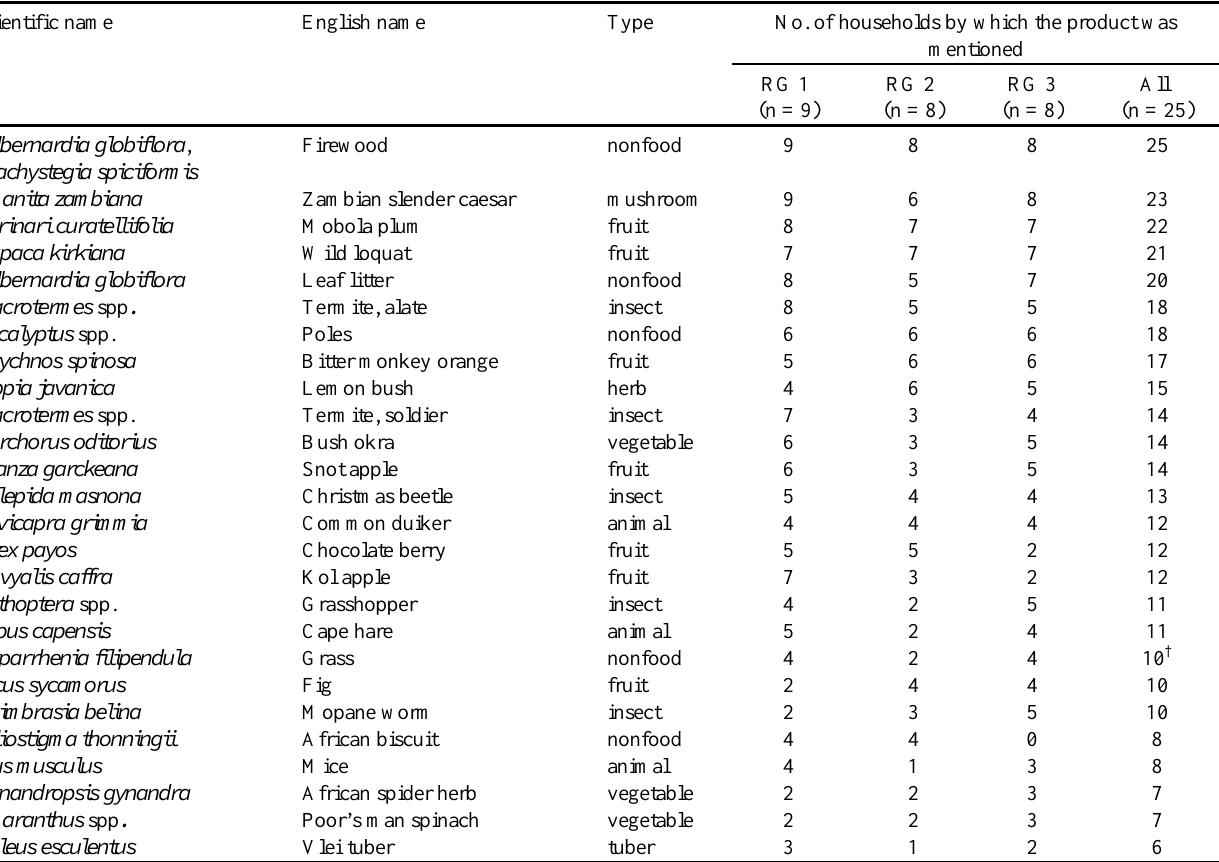
Table 2 . Frequency with which products collected from woodlands were mentioned by interviewed households, disaggregated by resource group (RG). This list shows the products that were most frequently mentioned. For a complete list see Appendix